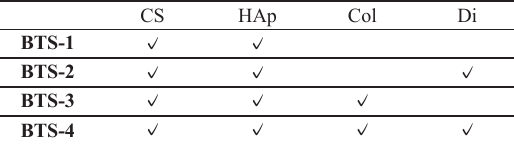
Table 1. Bio-composite scaffolds and their